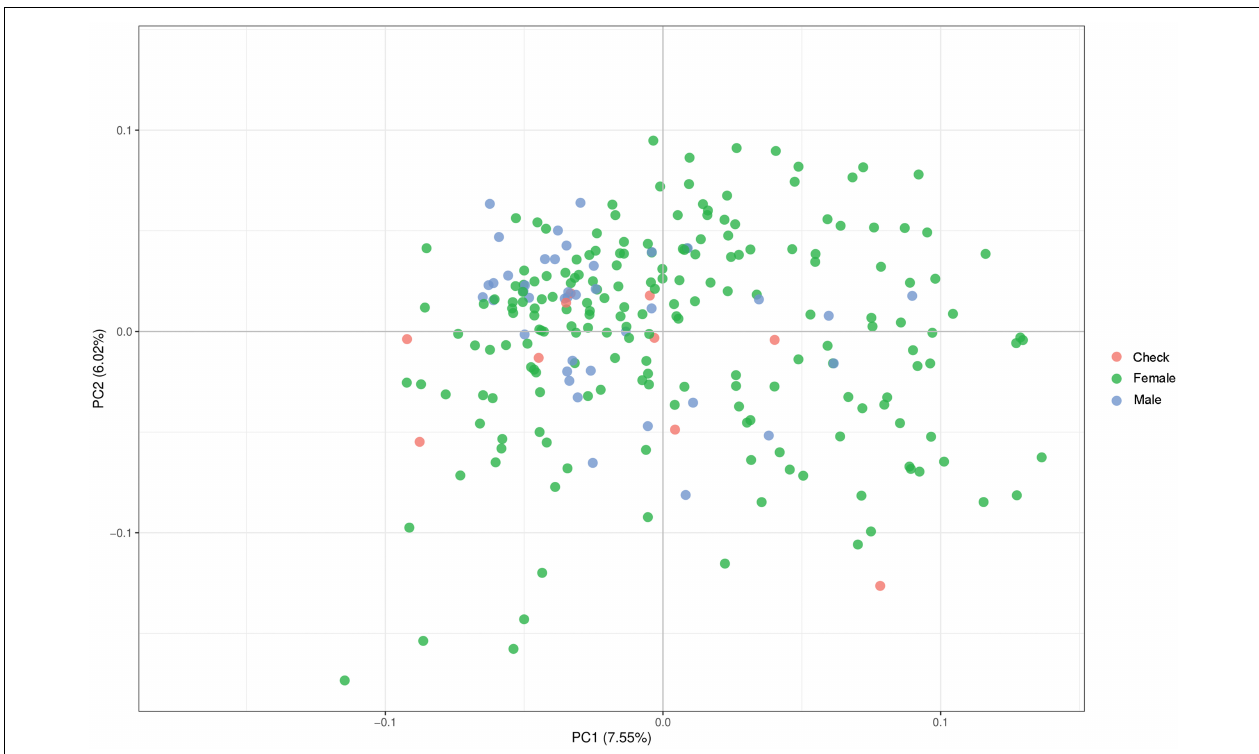
FIGURE 1 | Result of principal component analysis (PCoA) observing the relationship and aggregation of parental lines and check varieties based on Rogers’ distances calculated using genome-wide marker data.